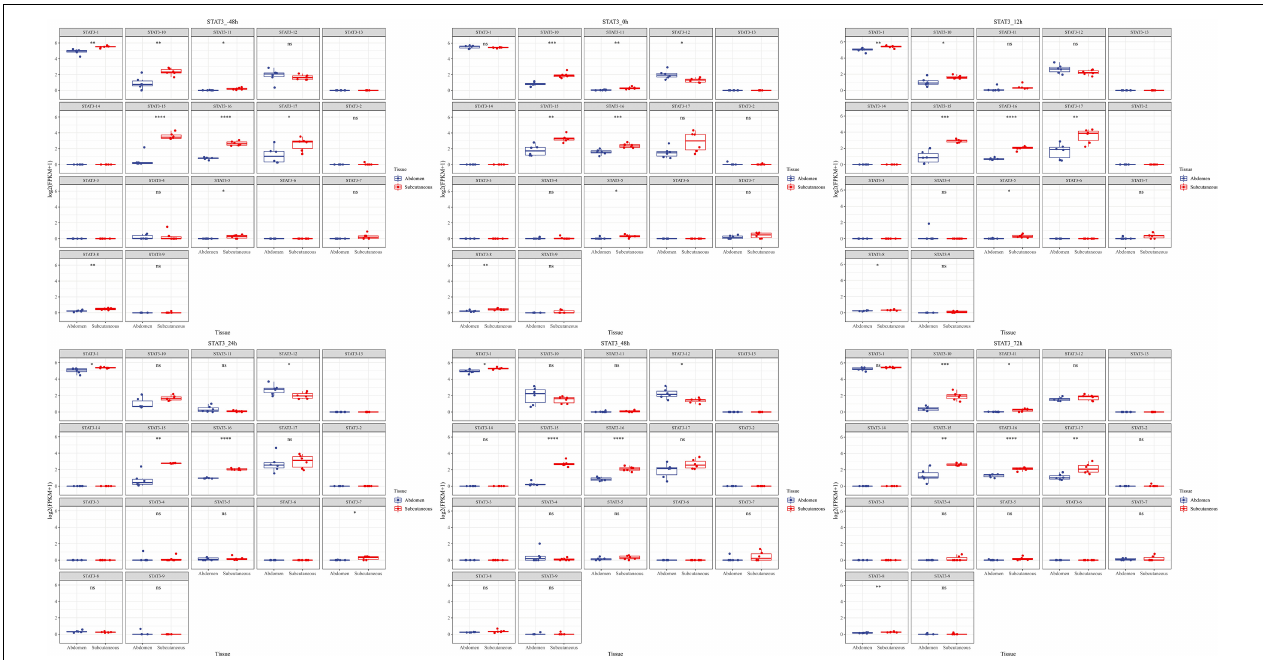
FIGURE 9 | Expression level of new transcripts of STAT gene at different time points of differentiation. Statistical change was determined by Student’s test (two tailed), * P < 0.05; ** P < 0.01; *** P < 0.001; **** P < 0.0001 as